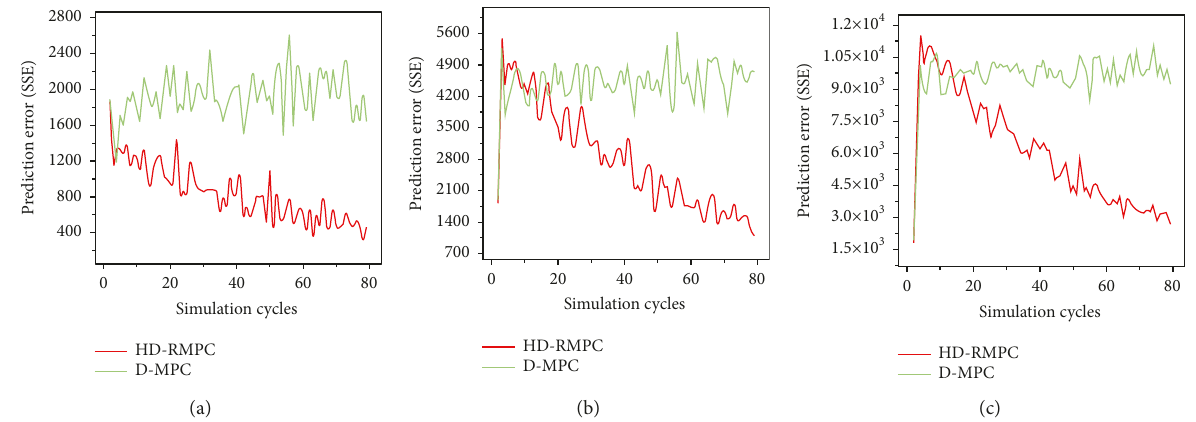
Figure 10: Comparison of prediction errors between HD-RMPC and D-MPC during simulation. (a) N